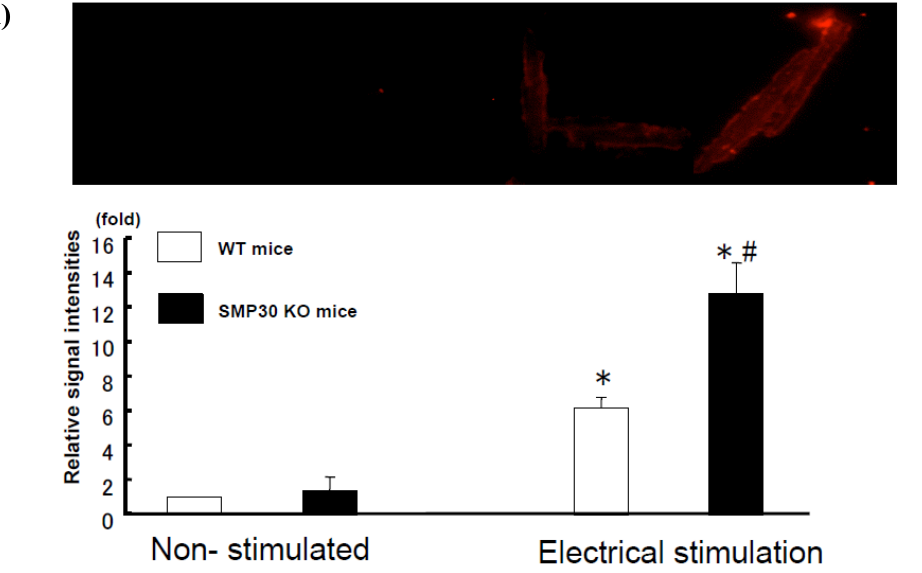
Figure 1. DHE and DCF staining in cardiac myocytes. Representative DHE ( A ) and DCF ( B ) staining in cardiac myocytes (Upper panel). Summary data of DHE and DCF staining in cardiac myocytes (Lower panel). The signals of DHE and DCF increased with electrical stimulation. DHE and DCF signals were more potent in SMP30 KO cardiac myocytes compared to WT cardiac myocytes with electrical stimulation. Values are expressed as the mean ± S.E.M. * p < 0.01 vs. non-stimulated, # p < 0.01 vs. WT mice in same staining ( n = 12